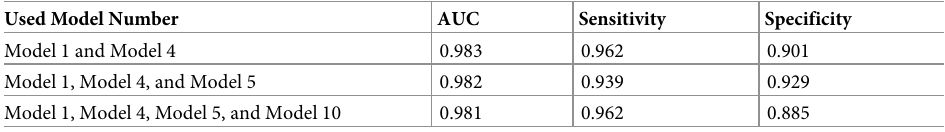
Table 4. Performance of the ensemble models.